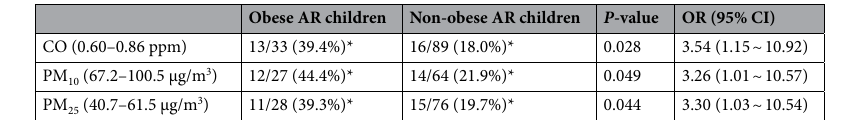
Table 5. When children with AR are exposed to higher air pollutant levels, the associations between high PRQLQ score (equal or higher than 92) and obesity. p -value: adjust for sex, age, parental occupation, second- hand smoke exposure, combined with asthma, mean ambient temperature and relative humidity within 7 days before the tests. *Number of children with high PRQLQ score/number of all children. OR: Odds Ratio.